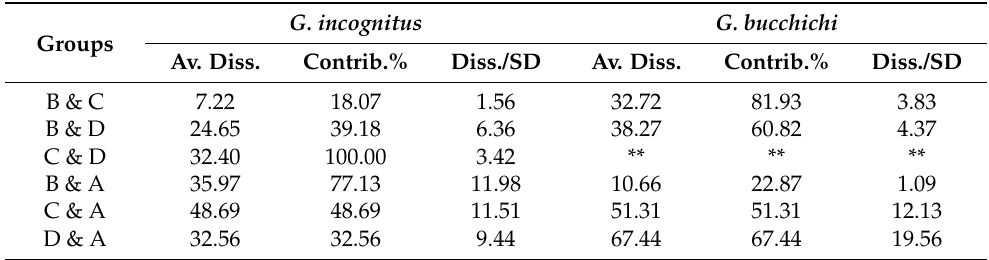
Table 2. Results of similarity percentage analysis (SIMPER) to analyze dissimilarity between groups (Av. Diss.: average dissimilarity; Contrib.: contribution; SD: standard deviation). ** - not available.